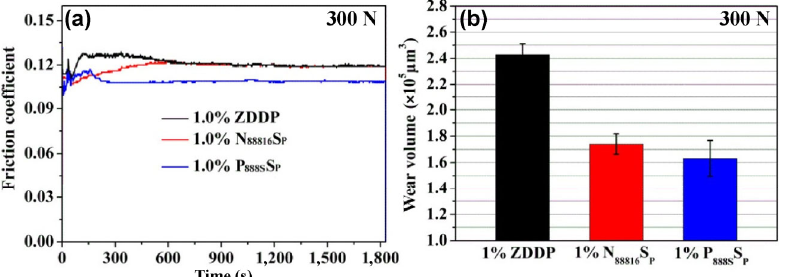
Fig. 5 Friction-reducing and anti-wear properties of ZDDP, N 88816 S P , and P 888S S P at similar mass concentrations of 1.0% for steel/steel contacts at 300 N, 25 Hz, and RT.